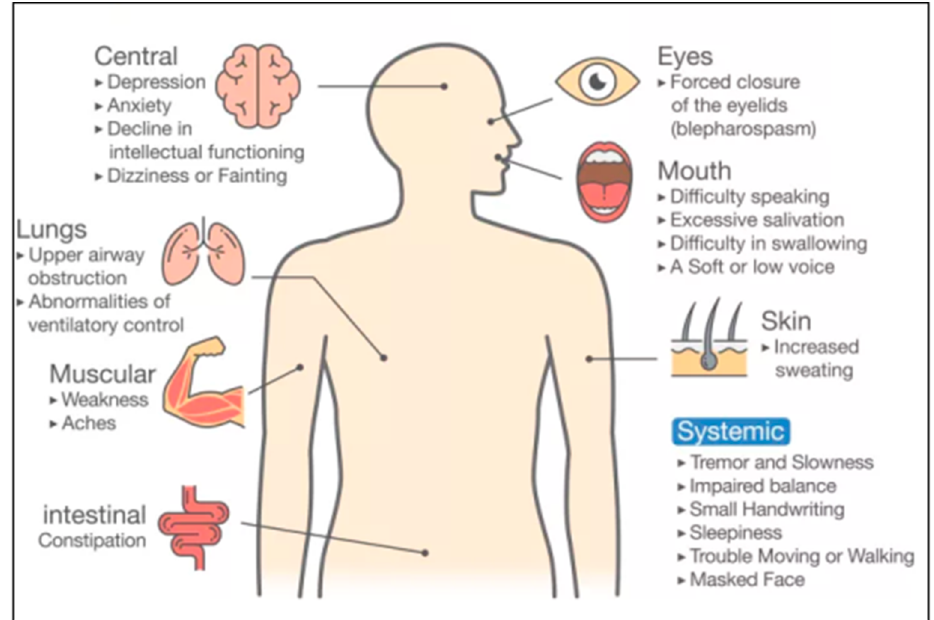
Figure 1. Symptoms of PD disease